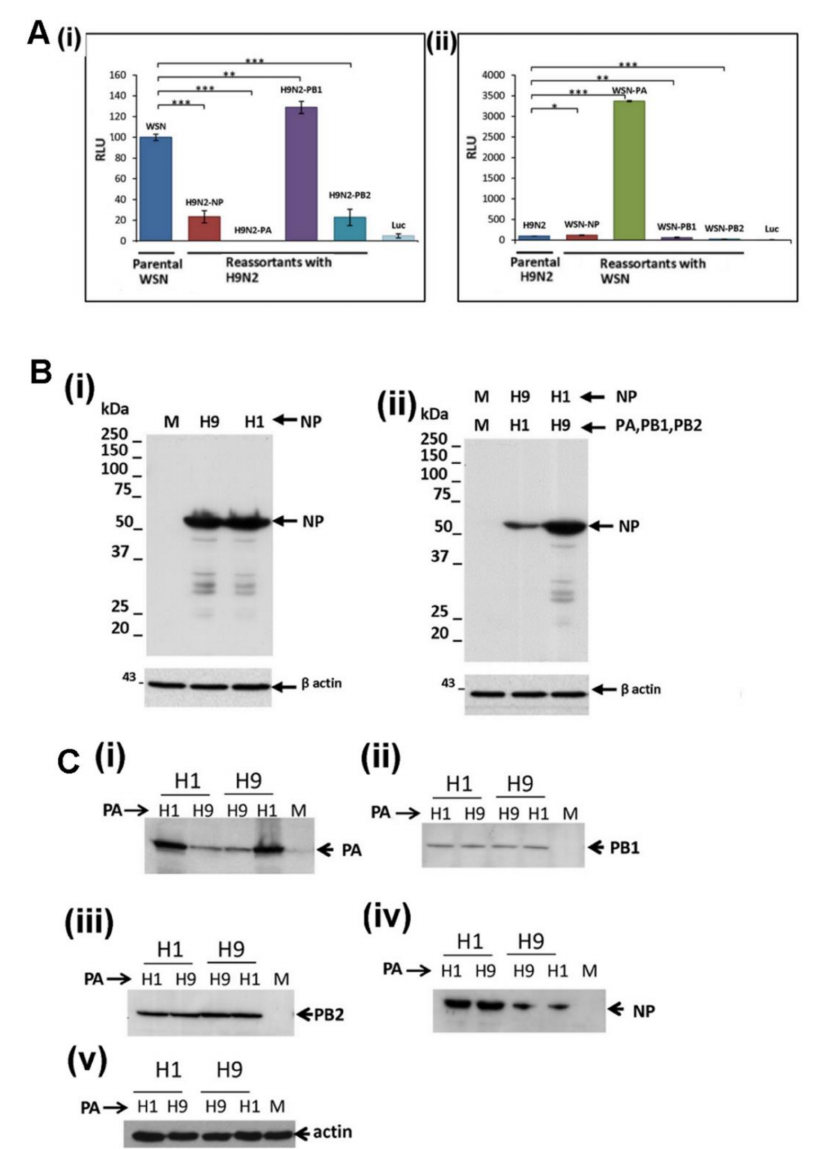
Figure 6. Activity of hybrid polymerase complexes formed between the H1N1 / WSN and H9N2 viruses. ( A ) Cells were co-transfected with the pCAGGS / PA, pCAGGS / PB1, pCAGGS / PB2, and pCAGGS / NP of the (i) H1N1 / WSN and (ii) H9N2 viruses and then replaced in turn with the corresponding pCAGGS / PA, pCAGGS / PB1, pCAGGS / PB2, pCAGGS / NP of (i) the H9N2 and (ii) the H1N1 / WSN viruses. The activity was measured by recording the luciferase at 4 days post-transfection. Each assay was performed in triplicate and representative data from one experiment is shown. The data was analyzed using the student T-test. Pairwise analysis values: * p < 0.05; ** p < 0.005; *** p < 0.001. ( B ) Cells were (i) singly transfected with the pCAGGS / NP of the H1N1 / WSN (H1) and H9N2 (H9) virus or (ii) co-transfected with the H1N1 / WSN (H1) virus pCAGGS / PA, pCAGGS / PB1, pCAGGS / PB2, and the H9N2 (H9) virus pCAGGS / NP or co-transfected with H9N2 (H9) virus pCAGGS / PA, pCAGGS / PB1, pCAGGS / PB2, and the H1N1 / WSN pCAGGS / NP. At 24 hrs post-transfection the cells were immunoblotted with anti-NP. The location of the NP is indicated (black arrow) and actin is a loading control. Cells transfected with pCAGGS are also shown (M). (C) Cells were co-transfected with the pCAGGS / PB1, pCAGGS / PB2, pCAGGS / NP of the (H1) H1N1 / WSN and (H9) H9N2 viruses and the pCAGGS / PA of the H1N1 / WSN virus (H1) or H9N2 virus (H9). At 24 h post-transfection the cells were immunoblotted with (i) anti-PA, (ii) anti-PB1, (iii) anti-PB2 and (iv) anti-NP. Protein bands corresponding in size to the full-length (black arrow) polymerase proteins are indicated, and (v) actin is a loading